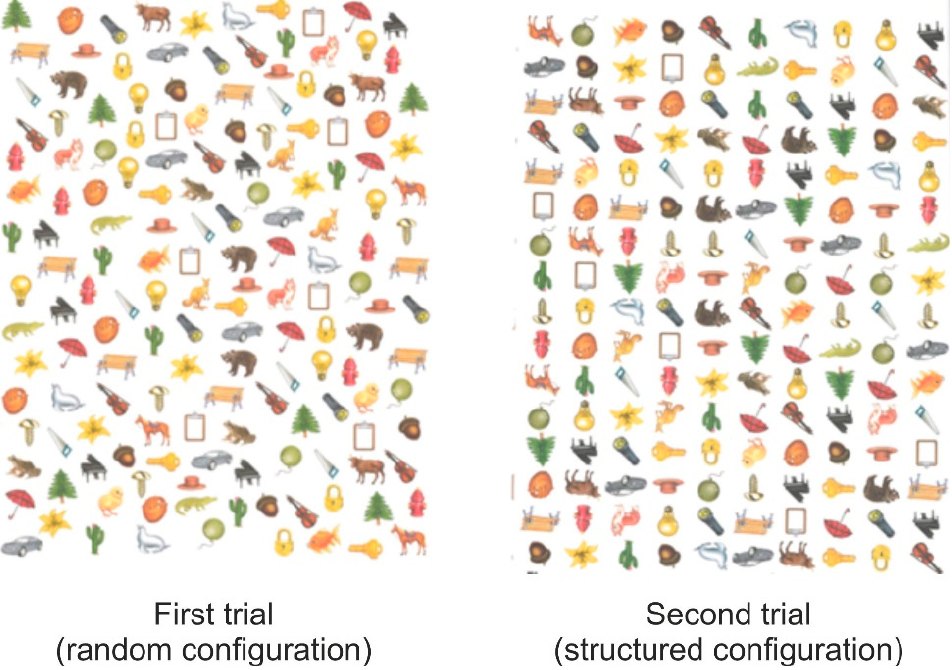
Figure 2. Cancelation test of the WISC-IV scale.